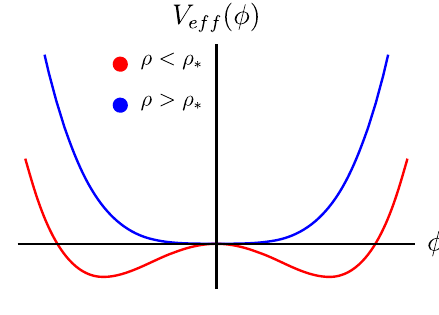
Fig. 2 The effective potential for the symmetron when ρ < ρ (cid:16) (red, lower) and when ρ > ρ (cid:16) (blue,